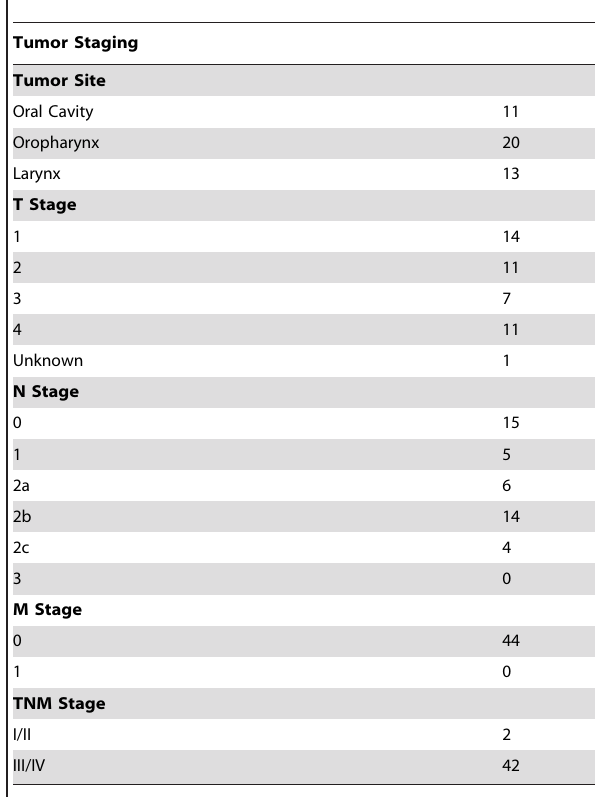
Table 2. Discovery tumor clinical characteristics.